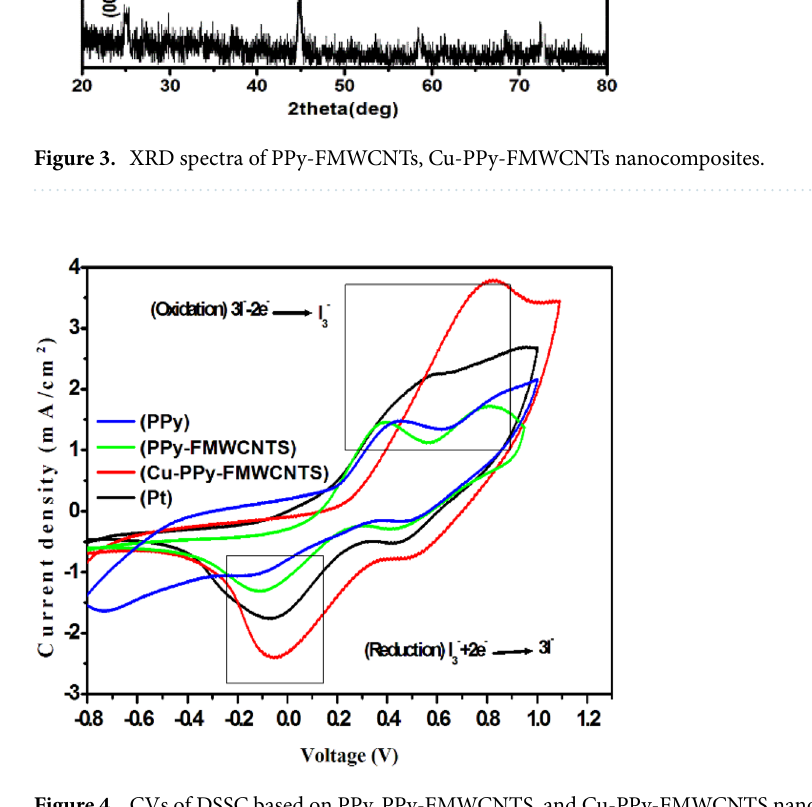
Figure 4. CVs of DSSC based on PPy, PPy-FMWCNTS, and Cu-PPy-FMWCNTS nanocomposites